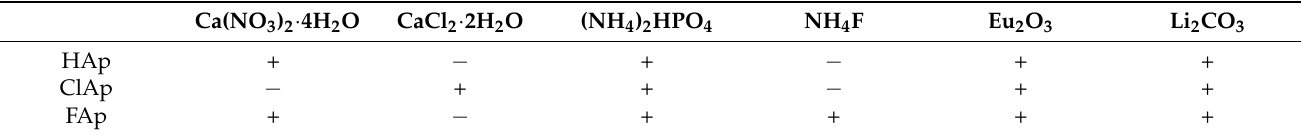
Table 1. Reagents used for the synthesis of nanoapatites (+ means reagent used, − means reagent not